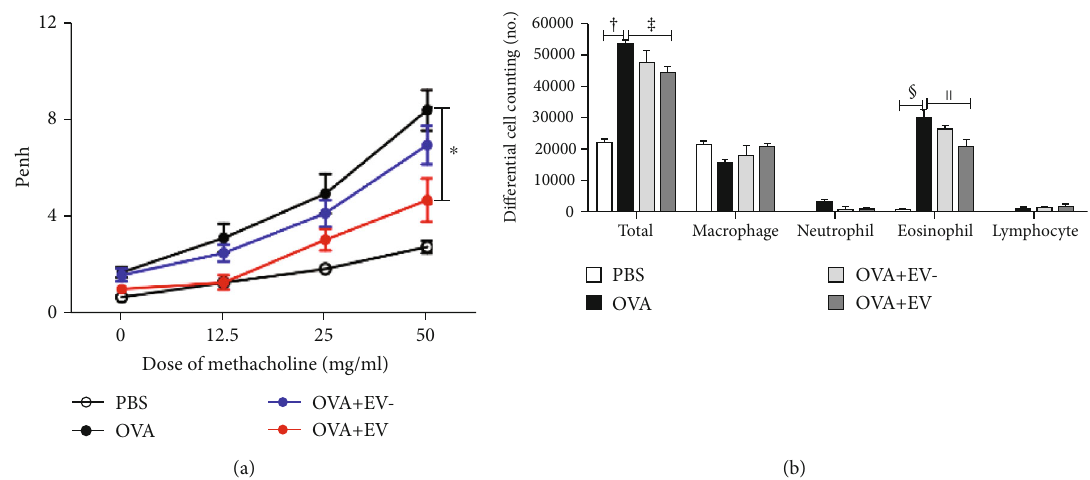
Figure 3: E ff ects of adipose stem cell- (ASC-) derived extracellular vesicles (EVs) on airway hyperresponsiveness (AHR) and di ff erential cell counts in bronchoalveolar lavage fl uid (BALF). (a) After the methacholine challenge, AHR decreased signi fi cantly in the OVA+EV group compared to the OVA group. (b) Total in fl ammatory cell and eosinophil counts in BALF signi fi cantly lowered in the OVA+EV group compared to the OVA group. Data are expressed as the mean ± SEM of four independent experiments, each performed in triplicate. ∗ p = 0 : 023 , † ,§ p < 0 : 001 , and ‡ p = 0 : 005